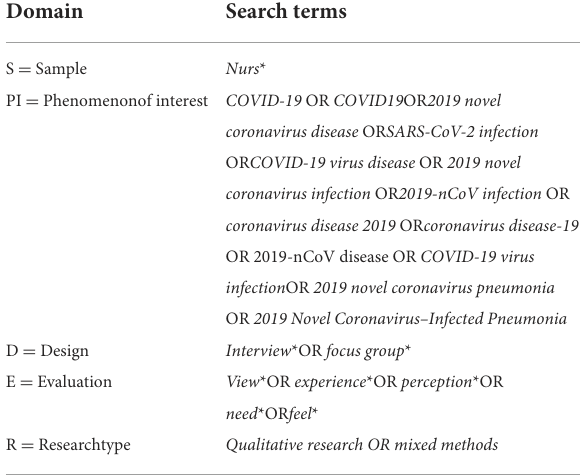
TABLE 1 Search terms used in systematic literature